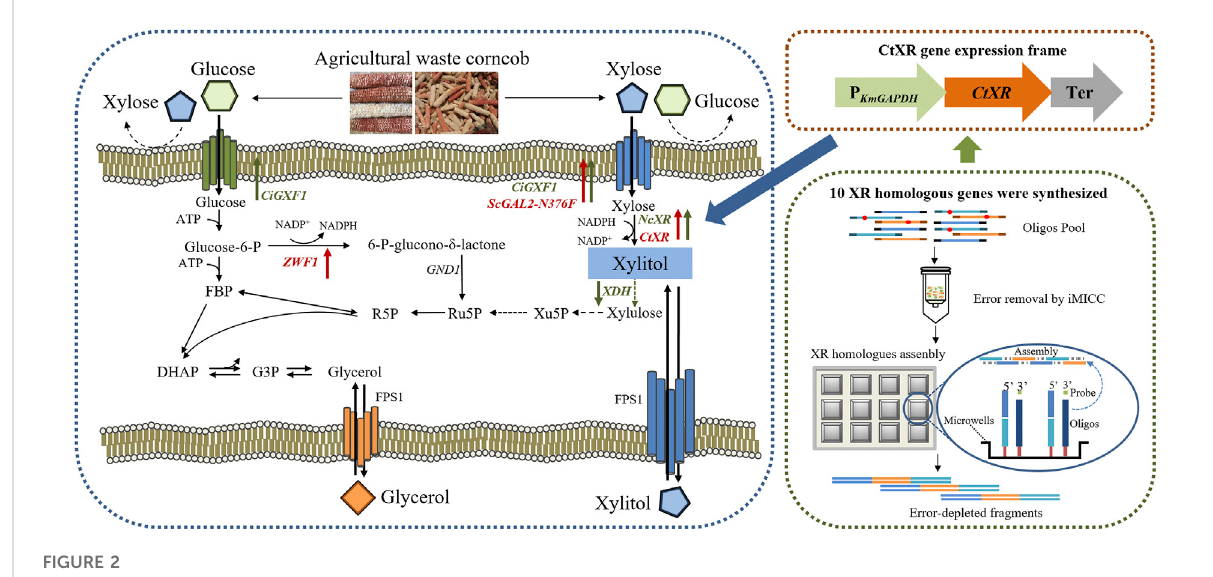
FIGURE 2 Schematic presentation of the metabolic pathway in modi fi ed K. marxianus strains. Upward arrows represent overexpression, and downward arrows represent disruption; the green ones were constructed in YZJ074 by Zhang et al. (2015), and the red ones were further constructed in this work.